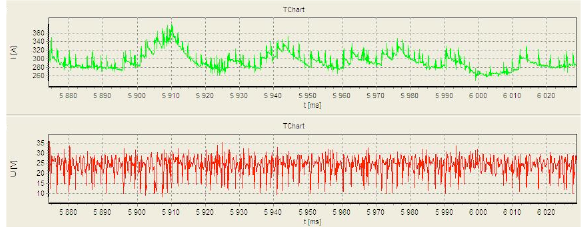
Fig.15. Short-spray process